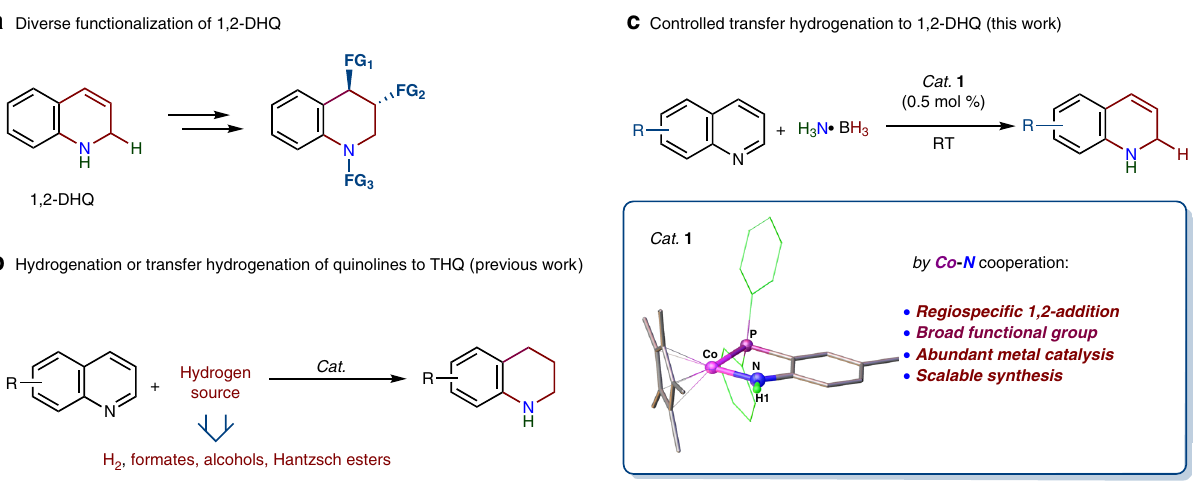
Fig. 1 Conversion of quinolines to THQs and 1,2-DHQs. a Diverse functionalization of 1,2-DHQ. b Hydrogenation and transfer hydrogenation of quinolines to THQs. c The present work on transfer hydrogenation of quinolines with H 3 N·BH 3 to 1,2-DHQs by a cobalt-amido cooperative